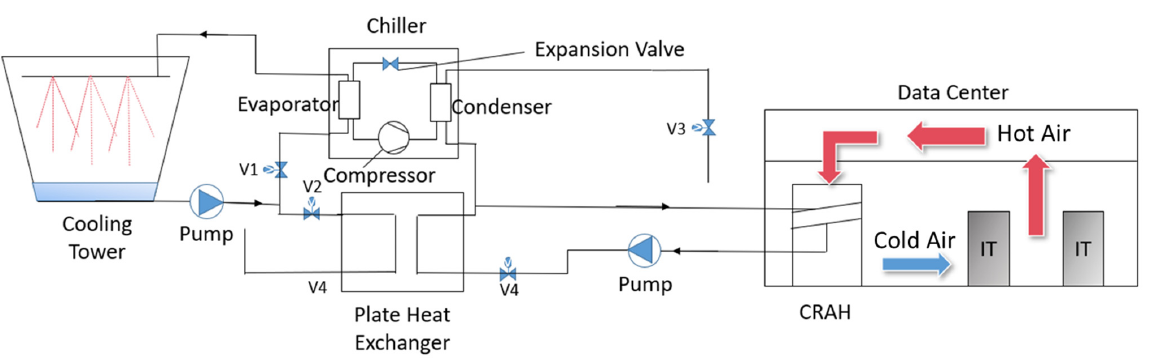
Figure 9. Plate heat exchangers in parallel with chillers. Table 1. Equipment and valve operating status in series system [40]. Cooling